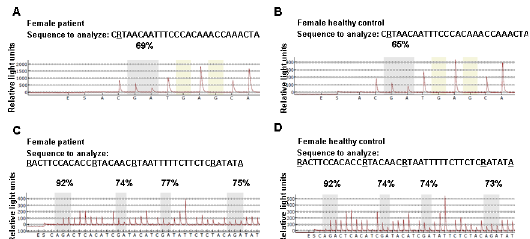
Fig 3. Methylations at specific CpG sites in a representative female patient and a healthy female control person. Methylations at one specific CpG site in FOXP3 promoter sequence 1 (position 1), and at four independent CpG sites in FOXP3 promoter sequence 2 (positions 1 to 4) of a representative female patient (A, C) and a healthy female control person (B, D) were quantified in a single pyrosequencing run. Position-specific information in the context of the analyzed sequence presents broad-sequence methylation patterns (% methylation). The built-in quality control sites (highlighted in yellow) consisting of cytosines converted to thymines demonstrate full bisulfite conversion of the treated